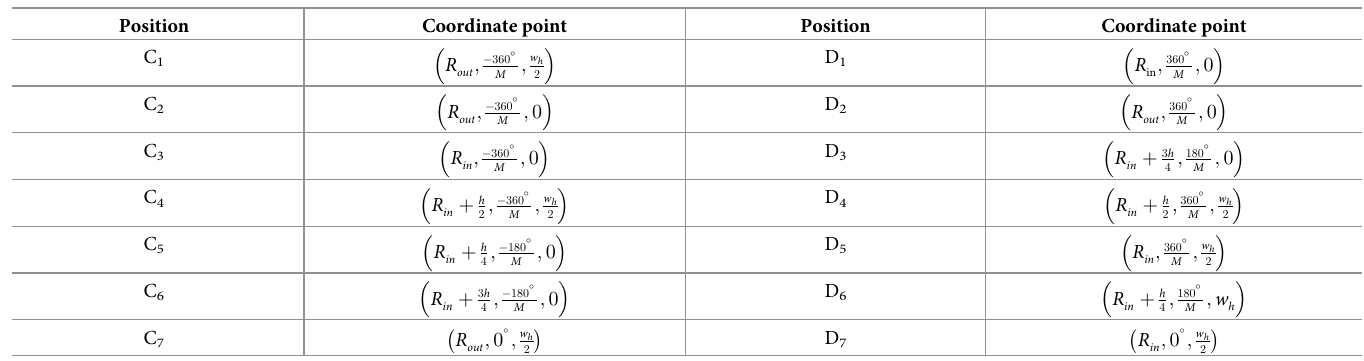
Table 2. Coordinates of C i and D i points in cylindrical coordinate system.